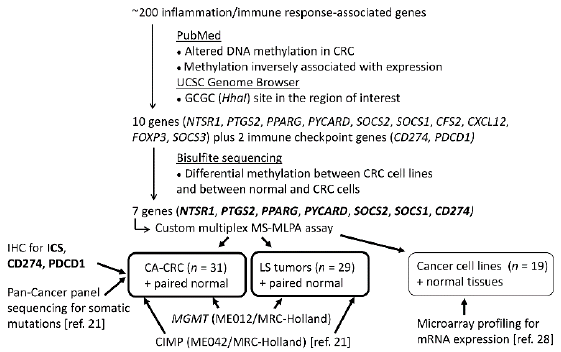
Figure 1. Flow chart of this investigation.